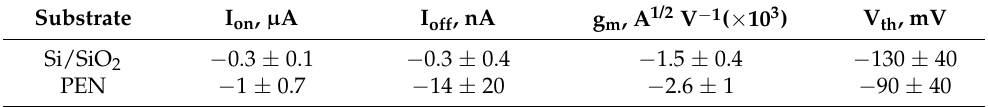
Table 1. Averaged electrical parameters of the EGOFET devices manufactured on different substrates.